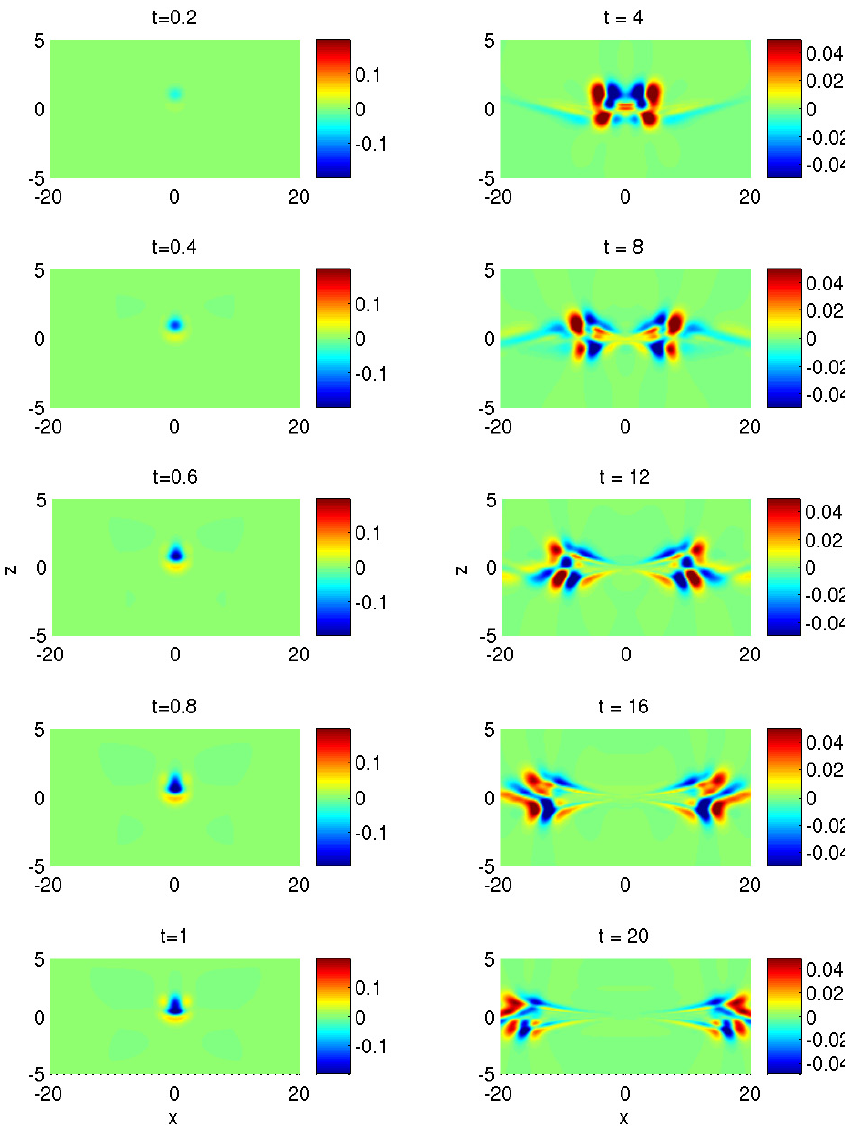
Fig. 4. Thermal pressure p(x,z,t) in the x-z-plane for various times. As in Fig. 3 the left column displays the first Alfv ´ en time and the right column corresponds to the further evolution of the perturbations. Here also the eigenmode structure (a mixing of kink and sausage mode) propagates along the static magnetic field, but the initial fast wave does not have a strong effect on the thermal